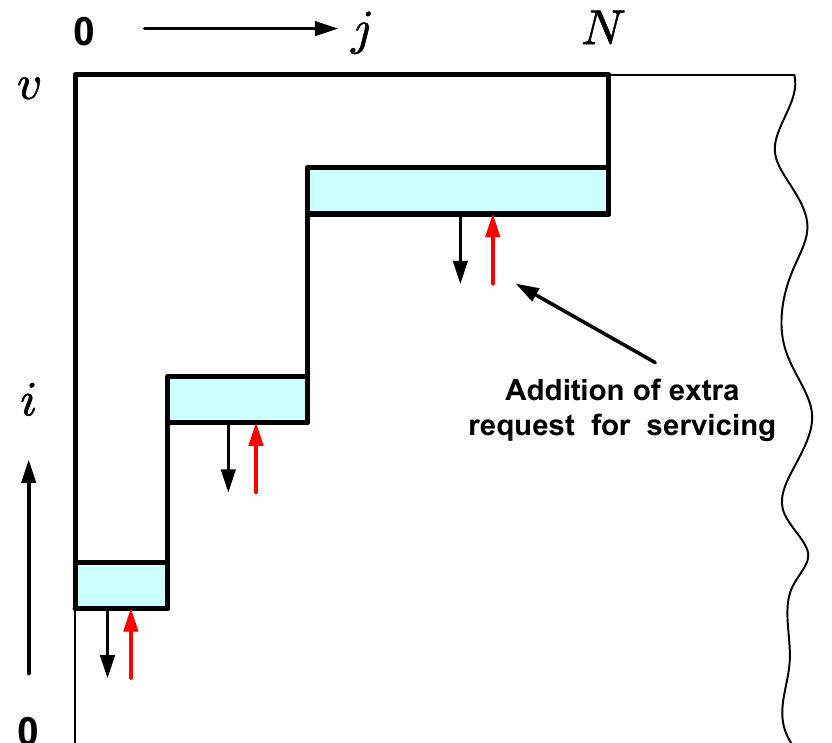
Figure A4. The procedure of construction of r ba ( t ) on R